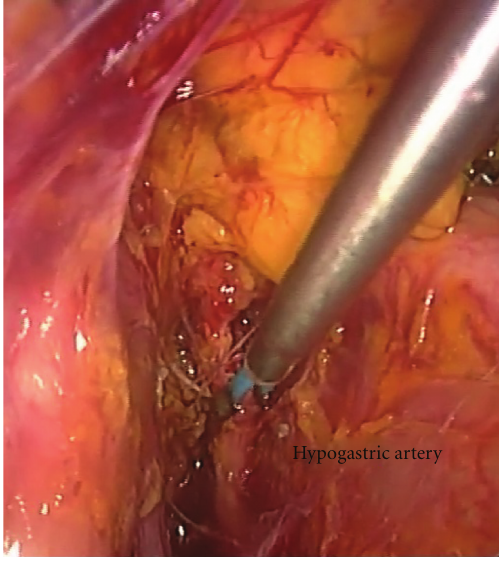
Figure 1: Hypogastric artery was isolated and coagulated with bipolar